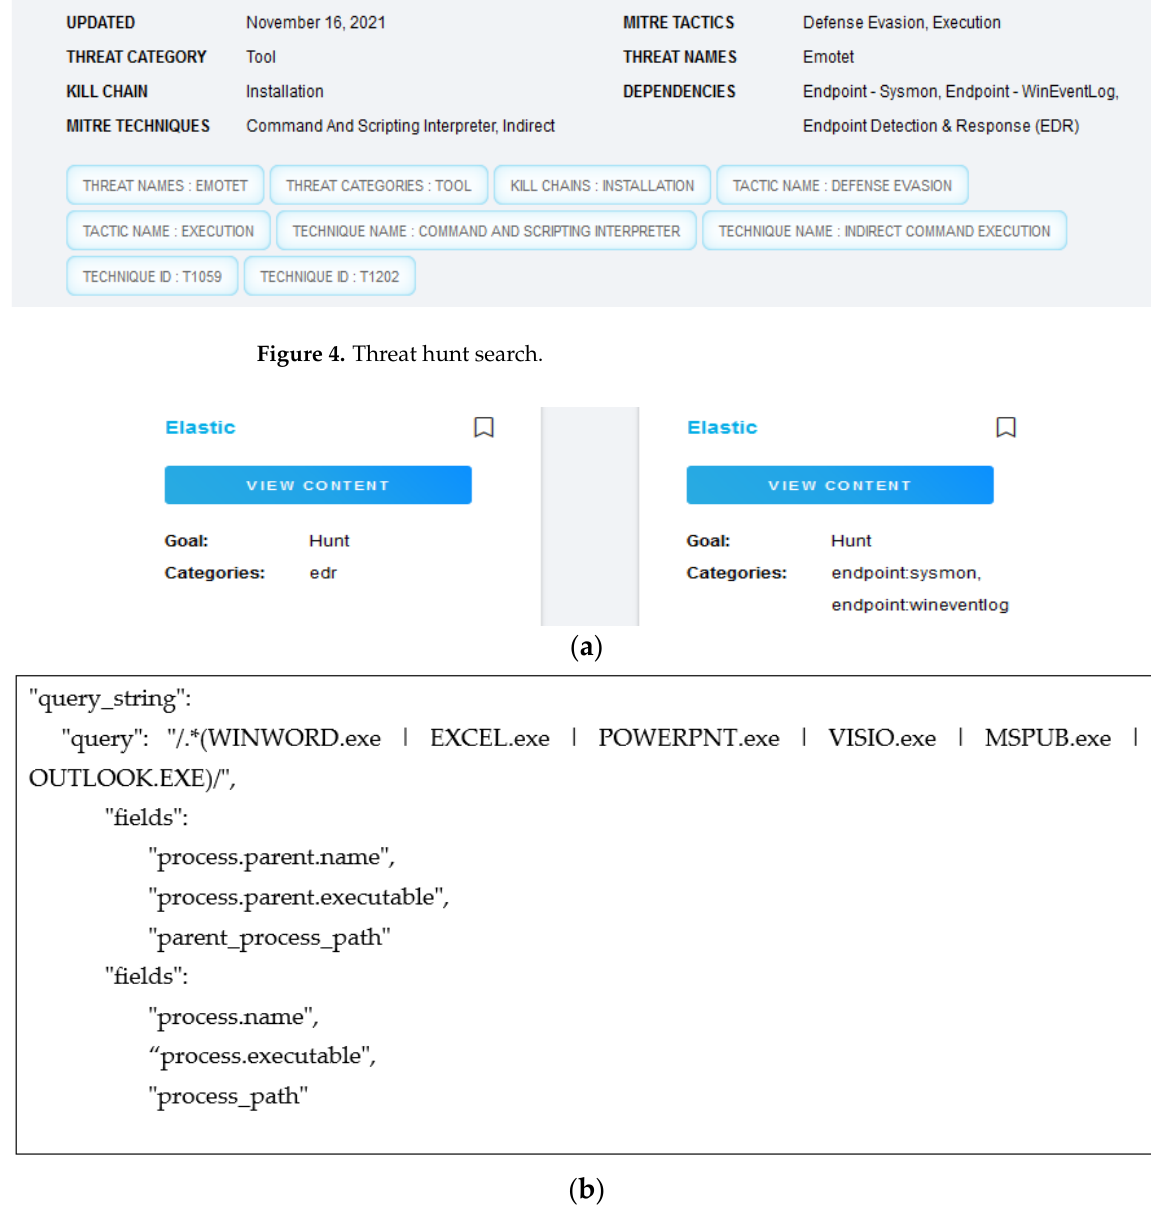
Figure 5. ( a ) Elastic Endpoint Sysmon. ( b ) Elastic Endpoint Sysmon script.